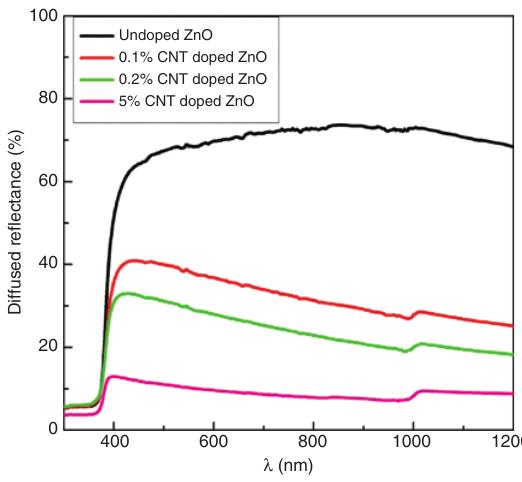
Figure 5 Diffused reflectance spectra of samples.